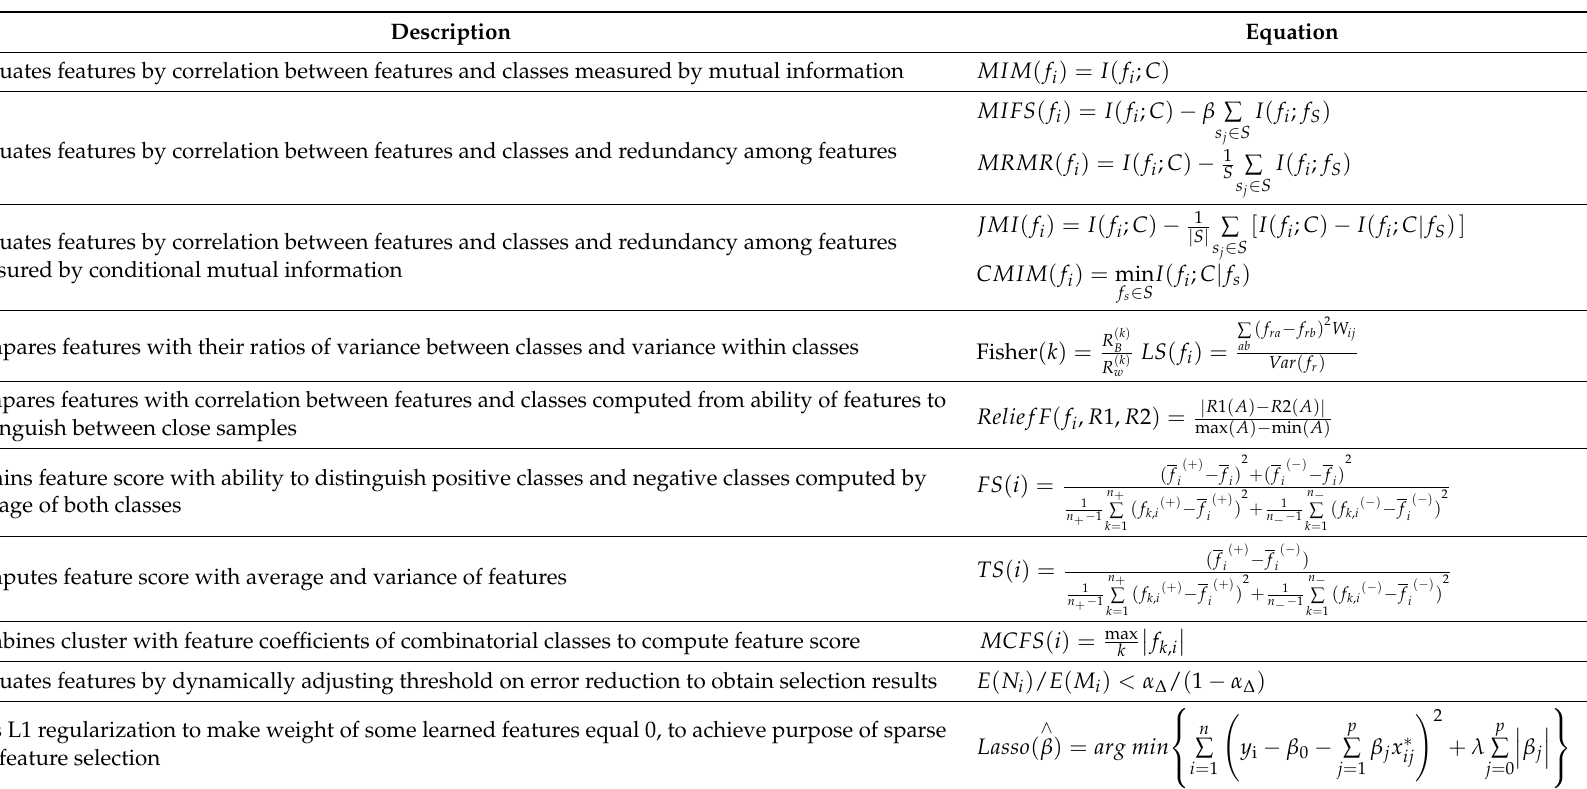
Table 2. Descriptions of the 13 feature selection methods in this